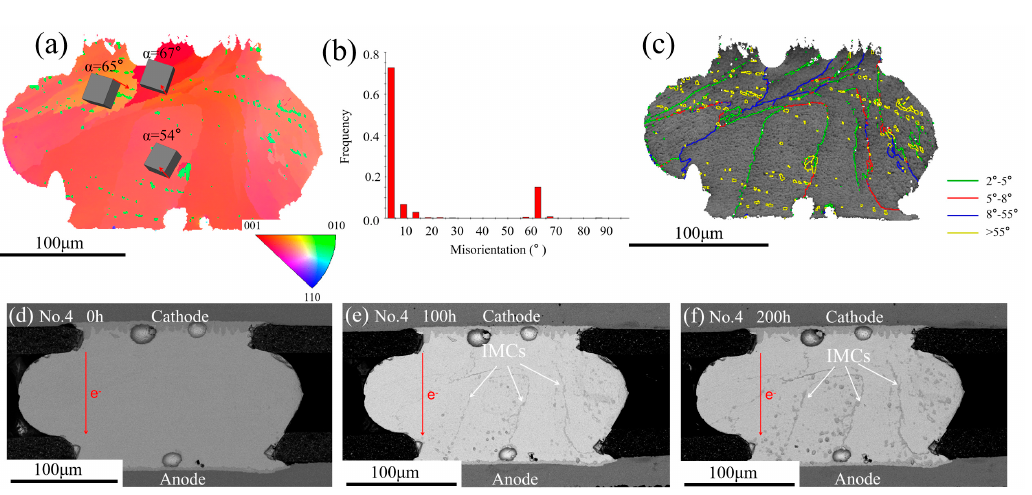
Figure 8. ( a ) EBSD map of the No.4 solder joint after reflow; ( b ) the misorientation distribution map; ( c ) the grain boundary distribution map; SEM images of the No.4 solder joint after different current stressing times: ( d ) 0 h; ( e ) 100 h; ( f ) 200 h.